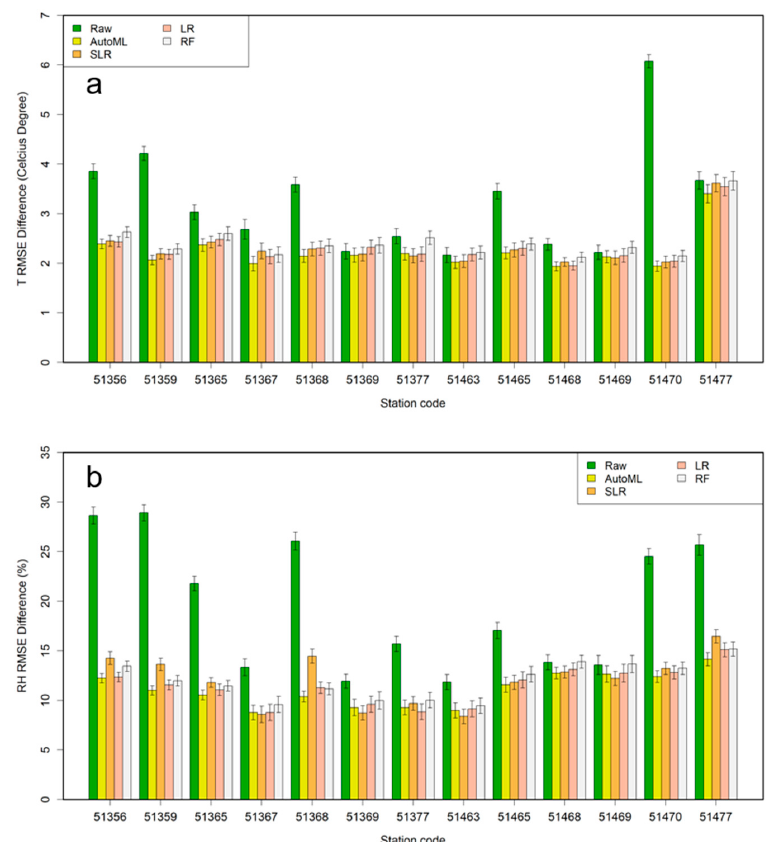
Figure 13. The bar-plot of mean RMSE values by raw forecast for ( a ) temperature and ( b ) relative humidity, AutoML, SLR, LR, and RF models evaluated with bootstrap sampling method. The uncertainty bar was added.